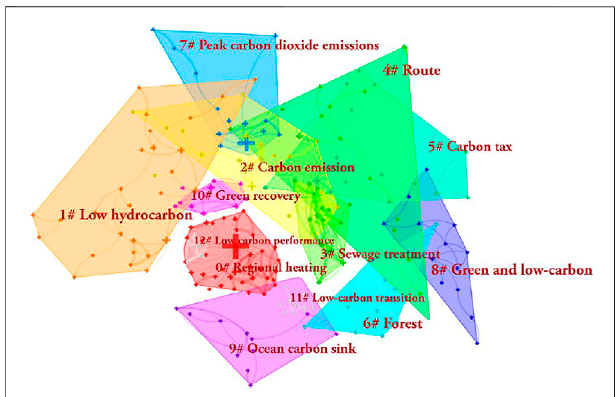
FIGURE 6 | Carbon neutrality study keyword clustering